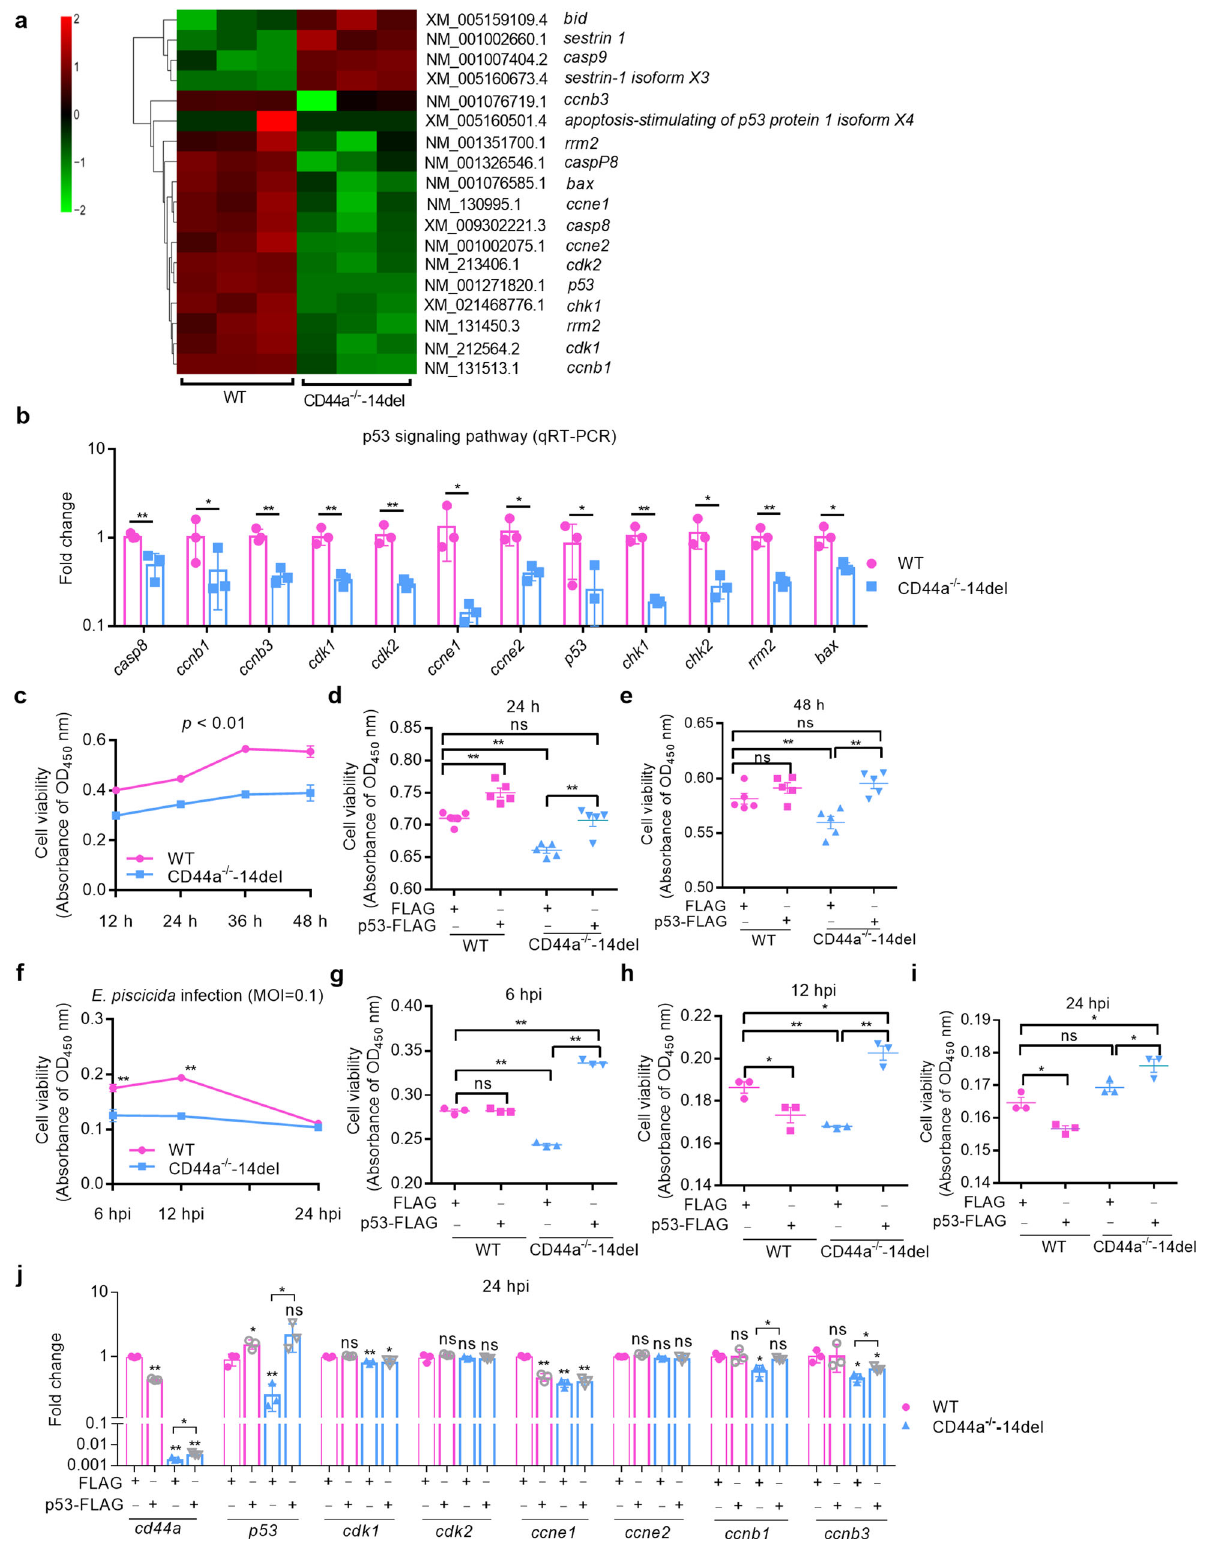
abolished by Z-IETD-FMK treatment, but not for zebra fi sh CD44a_tv2 (Figs. 1d and 7g). Furthermore, overexpression of zebra fi sh CD44a_tv1 increased levels of late apoptosis, and the induced late apoptosis by zebra fi sh CD44a_tv1 was signi fi cantly weakened by the treatment of Z-IETD-FMK (Fig. 7h and Supplementary Fig.